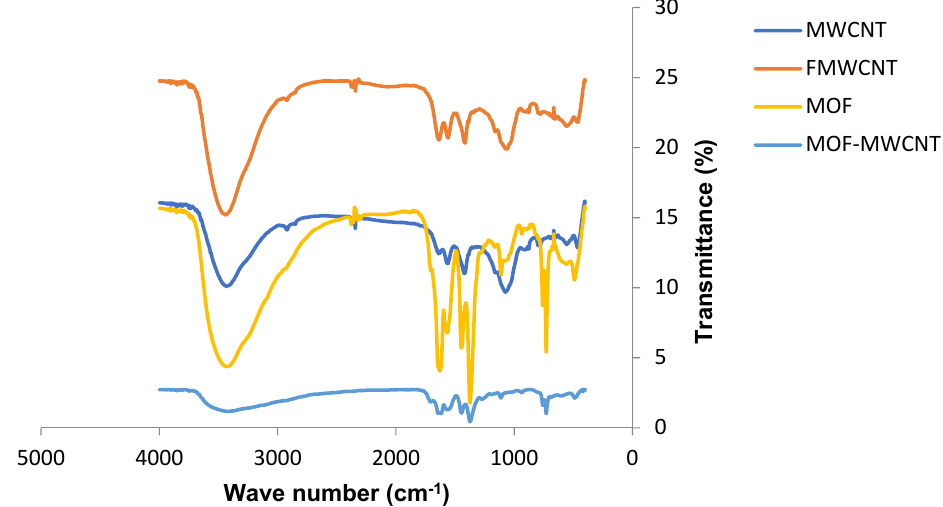
Figure 6. FTIR spectra of the as-received MWCNTs, acid-treated MWCNTs, HKUST-1 MOFs, and FMWCNT/HKUST-1 composites.